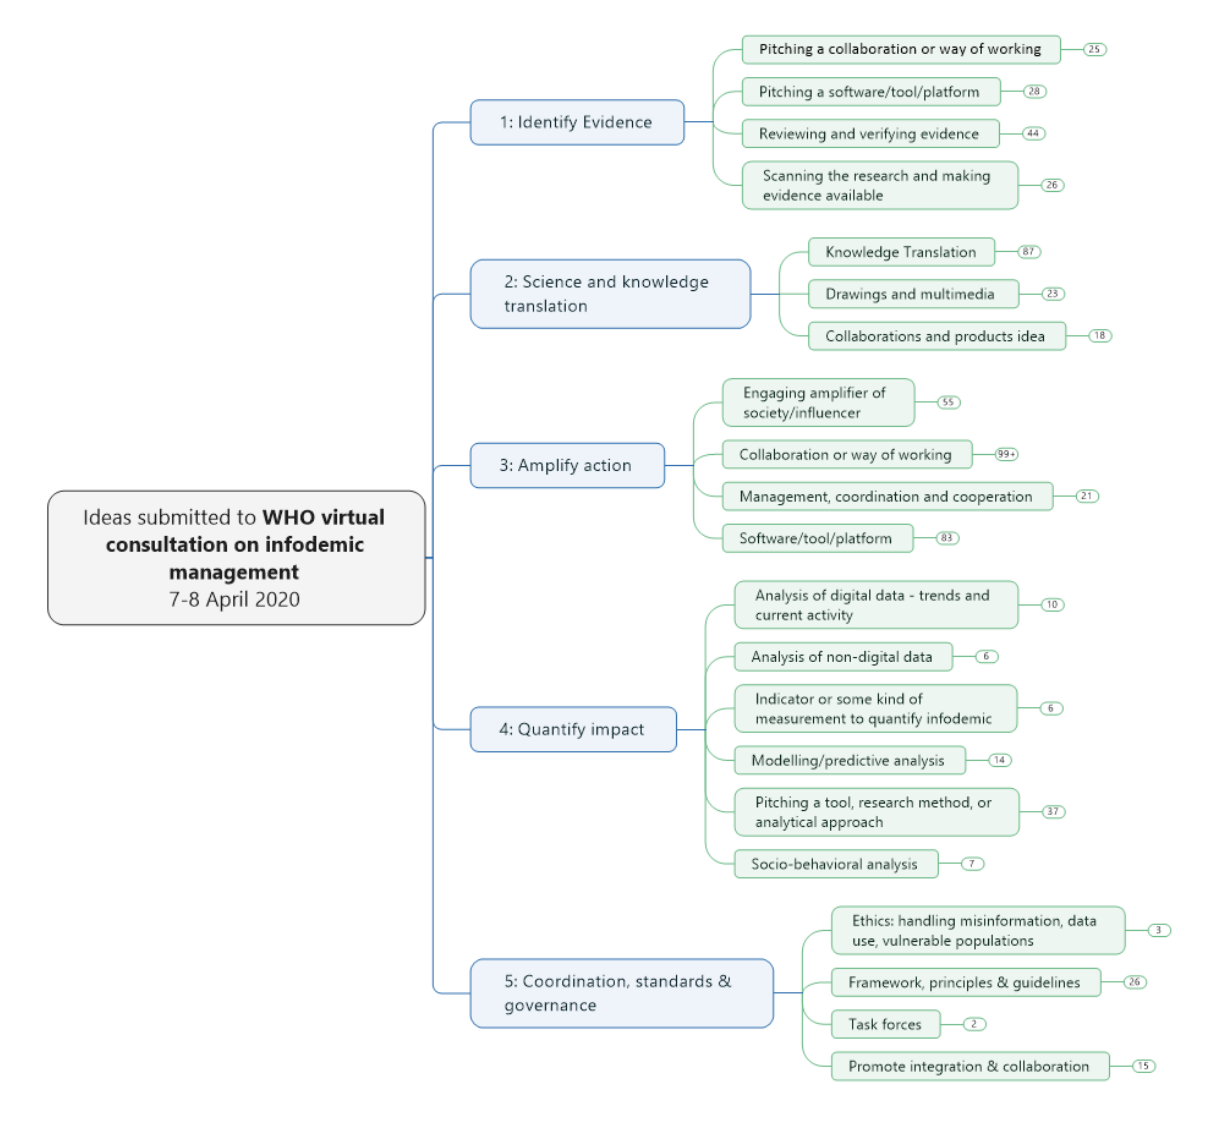
Figure 1. Summary categorization and count of ideas submitted by the end of the consultation period. WHO: World Health